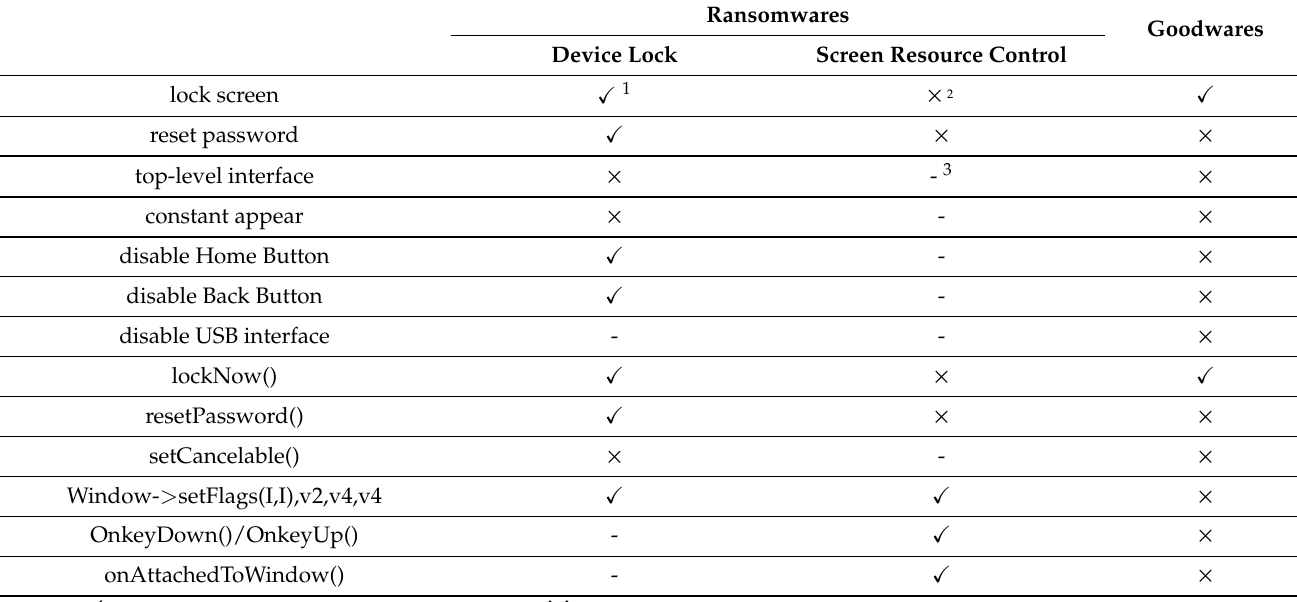
Table 4. Differences between device lock and screen resource control ransomware and goodware applications. Ransomwares Goodwares Device Lock Screen Resource Control